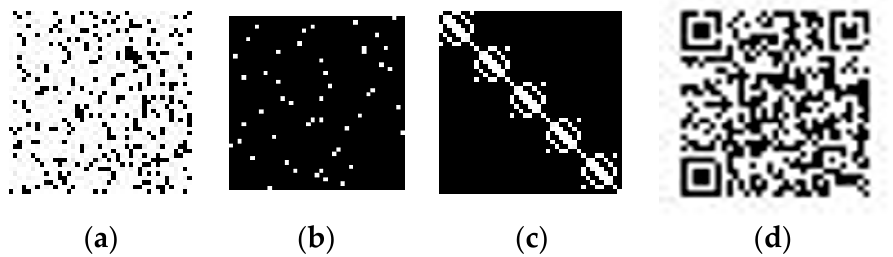
Figure 13. QR code reconstruction from share added with noise ( a ) S 1 (6th QR code), ( b ) S 2 (6th QR code), ( c ) S 3 (6th QR code), ( d ) Reconstructed QR code.